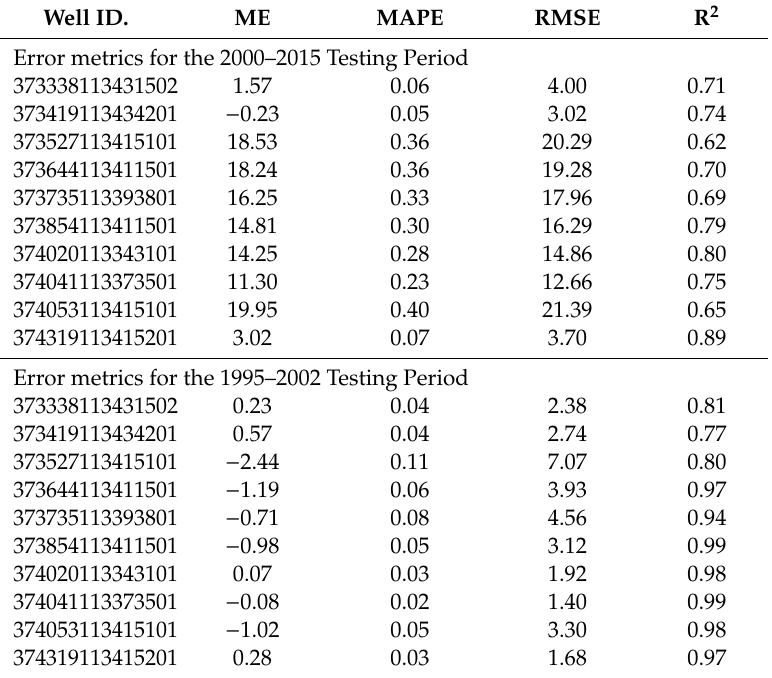
Table 3. ME, MAPE, RMSE and R 2 values for ELM Time Series Prediction for Ten Wells in Beryl Enterprise Aquifer for both the 2000 – 2015 and 1995 – 2002 testing periods.